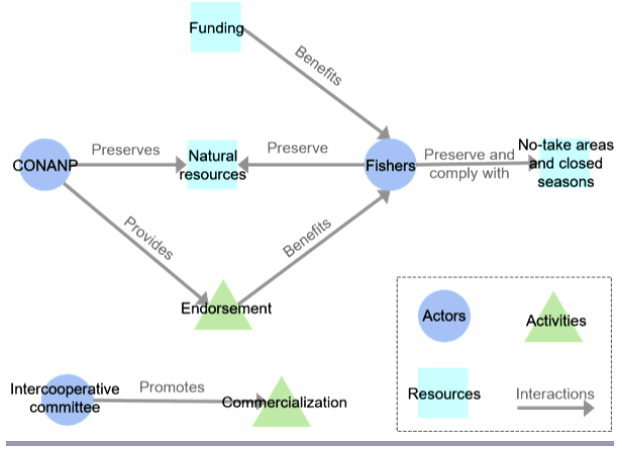
Fig. 2 . Group mental model of the leaders of fishing cooperatives.